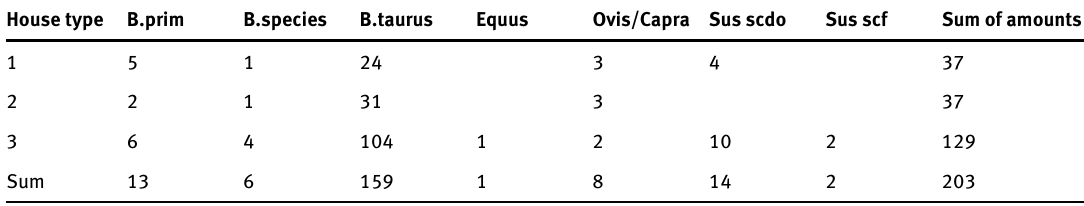
Table 2b: Bylany (distr. Kutná Hora), pottery phases 9 to 25. Frequency of animal bones in house types. Data after Peške, Rulf, Slavíková